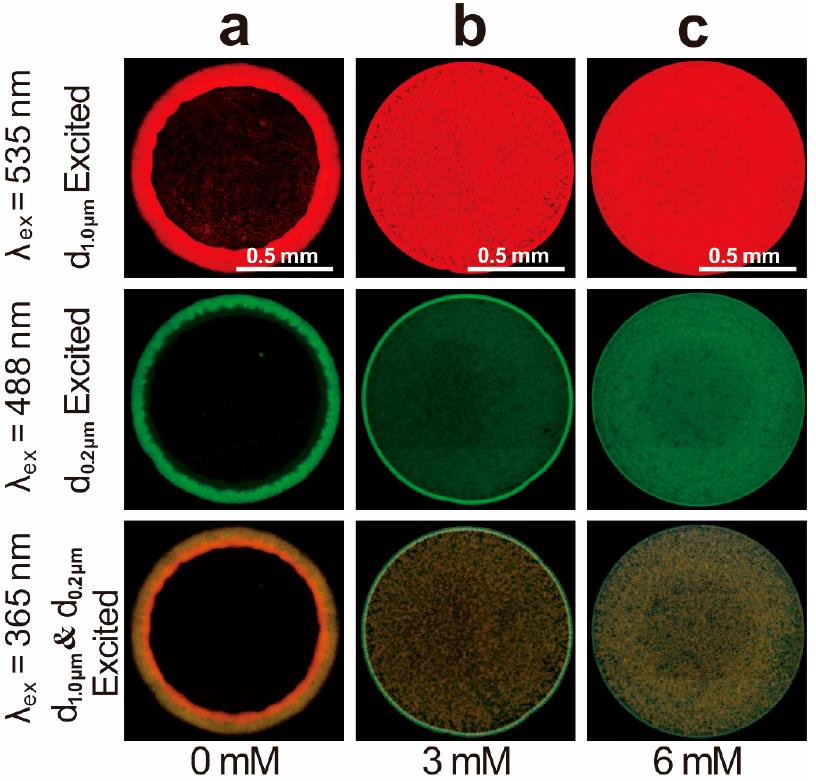
Figure 2. Fluorescence images of the deposit patterns dried from suspension droplets containing bi-dispersed F-PS particles (1.0 µ m and 0.2 µ m in diameters) and trace amounts of MgCl 2 on PET substrate. Concentrations of MgCl 2 : ( a ) 0 mM, ( b ) 3.0 mM and ( c ) 6.0 mM. Each column shows the images of the same deposit pattern under excited lights of different wavelengths. At λ ex = 535 nm (the first row), only the F-PS particles with a diameter of 1.0 µ m are observed with red color; At λ ex = 488 nm (the second row), only the F-PS particles with a diameter of 0.2 µ m are observed with green color; At λ ex = 365 nm (the third row), the F-PS particles with diameters of 1.0 µ m and 0.2 µ m are simultaneously observed with orange color and green color, respectively.